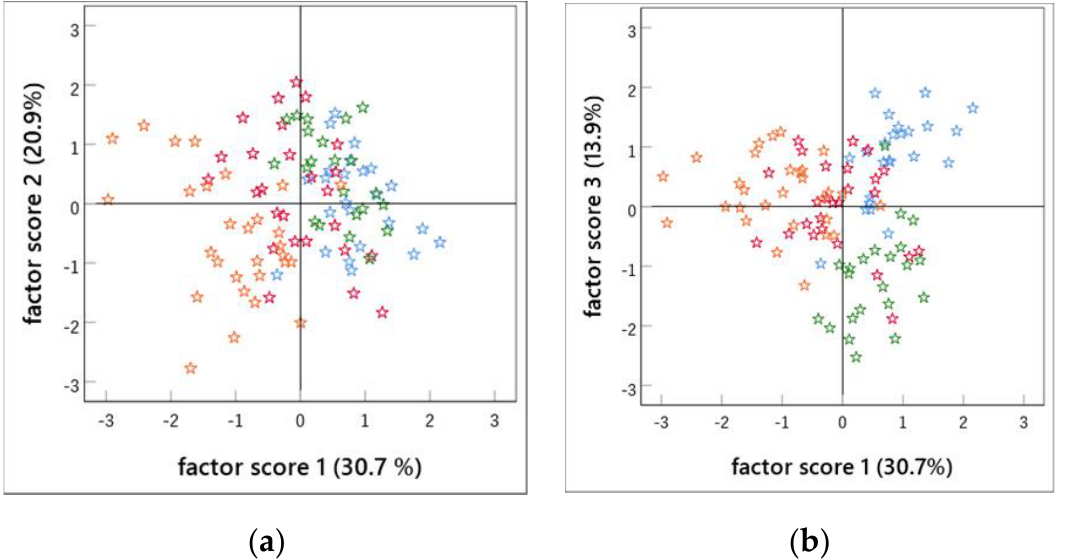
Figure 1. Principal component (PC) scores for the overall data set of ( a ) PC1 and PC2 and ( b ) PC1 and PC3. Each symbol corresponds to a single vine under severe pre-veraison water deficits (orange symbols, n = 29), moderate pre-veraison water deficits (red symbols, n = 26), moderate post veraison water deficits (green symbols, n = 22) and mild post veraison water deficits (blue symbols, n =